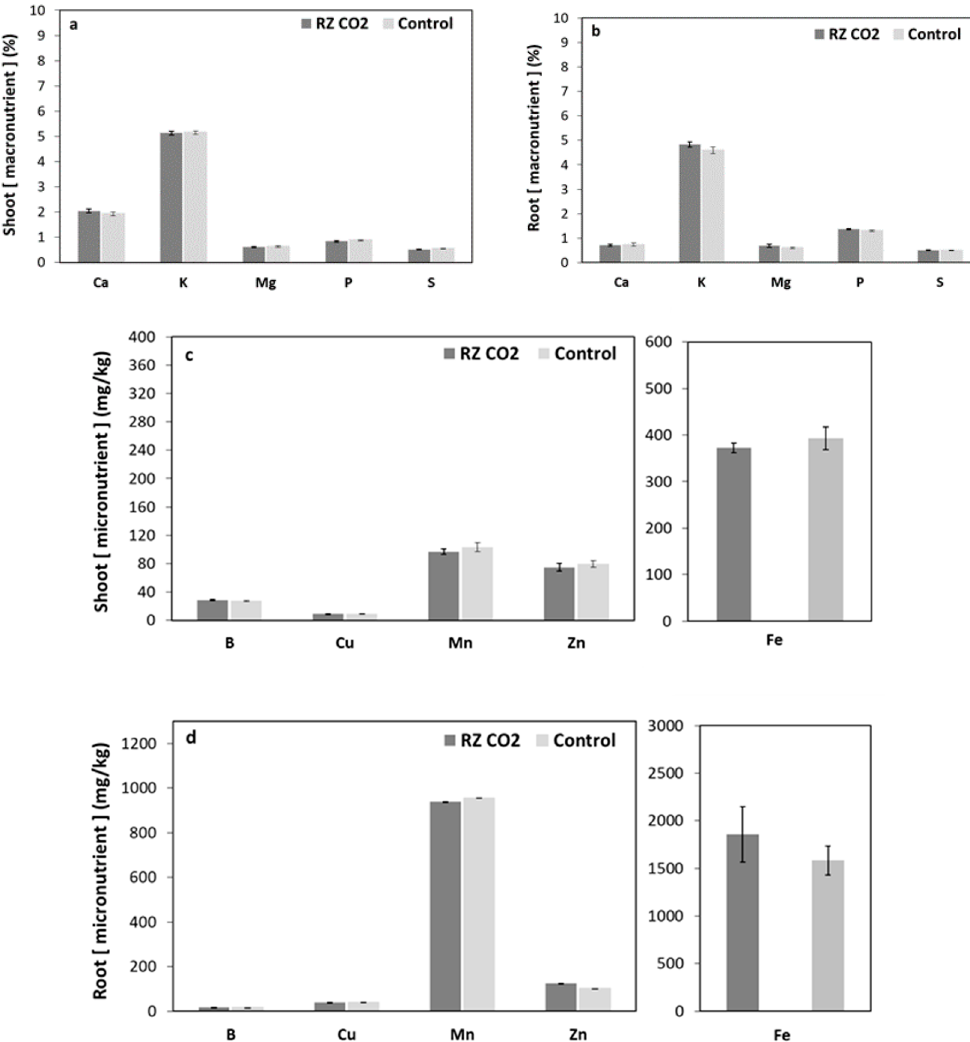
Figure 4. Elevated RZ CO 2 effects on pepper shoot ( a ) and root ( b ) macronutrients concentrations: calcium (Ca), potassium (K), magnesium (Mg), phosphorus (P) and Sulphur (S). Shoot ( c ) and root ( d ) micronutrients concentrations: boron (B), copper (Cu), iron (Fe), manganese (Mn) and zinc (Zn). Experiment 10. Bars are means ± SE of 8 replicates. Asterisks indicate significant differences between treatments (Independent Sample T-test, p -value < 0.05).